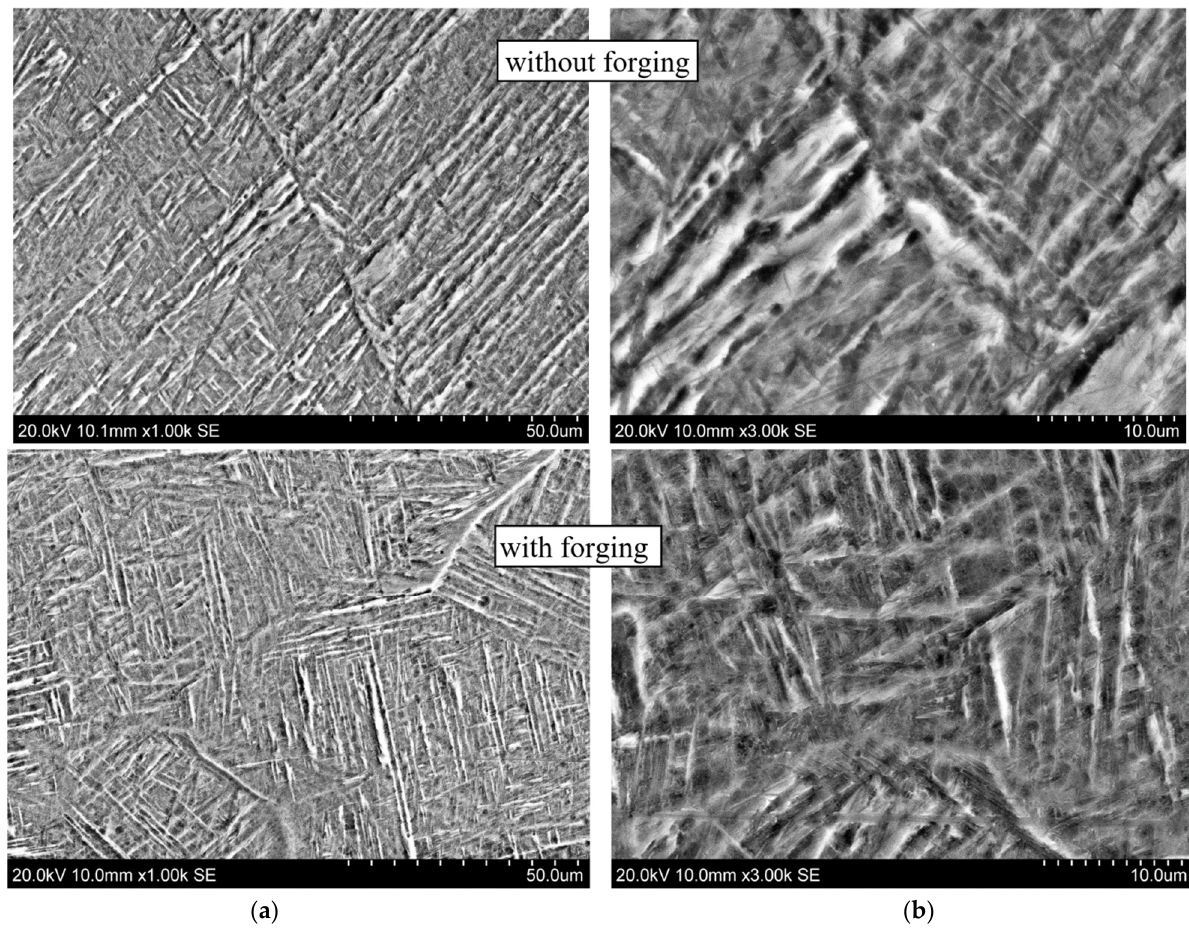
Figure 11. Microstructure of alloy Ti-6Al-4V. CMT deposition without and with forging at different magnifications: ( а ) ×1000; ( b ) ×3000.